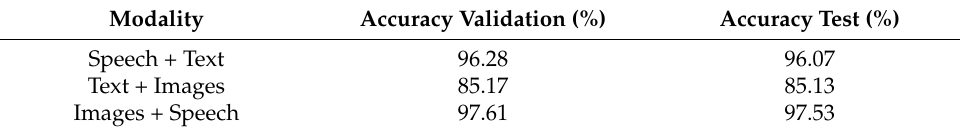
Table 7. Results of bimodal prediction of trust using top 2 performing models.